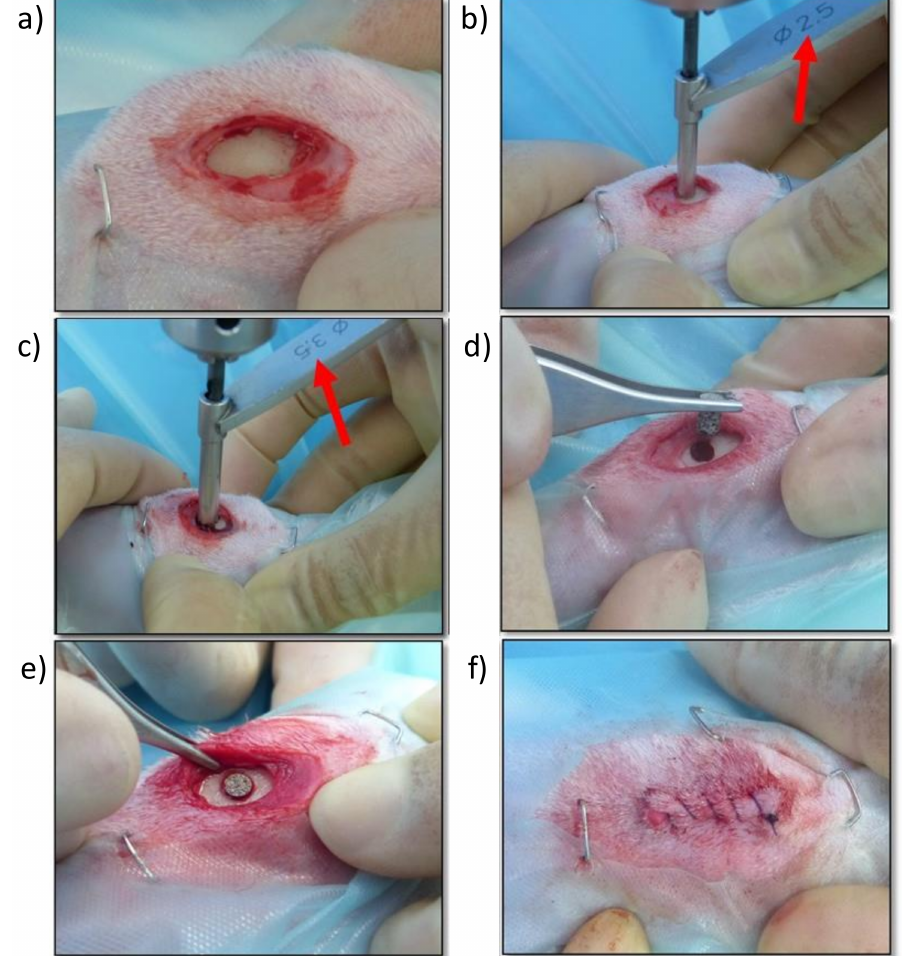
Figure 8. Screen photographic sequence of the surgical method: ( a ) Medial approach to the proximal aspect of the right tibia, ( b ) Creating a monocortical bone defect with a 2.5 mm drill bit, ( c ) Enlarg- ing the monocortical bone defect with a 3.5 mm drill bit, ( d ) Placing the titanium implant in the ( f ) Surgical wound sutured with a continuous